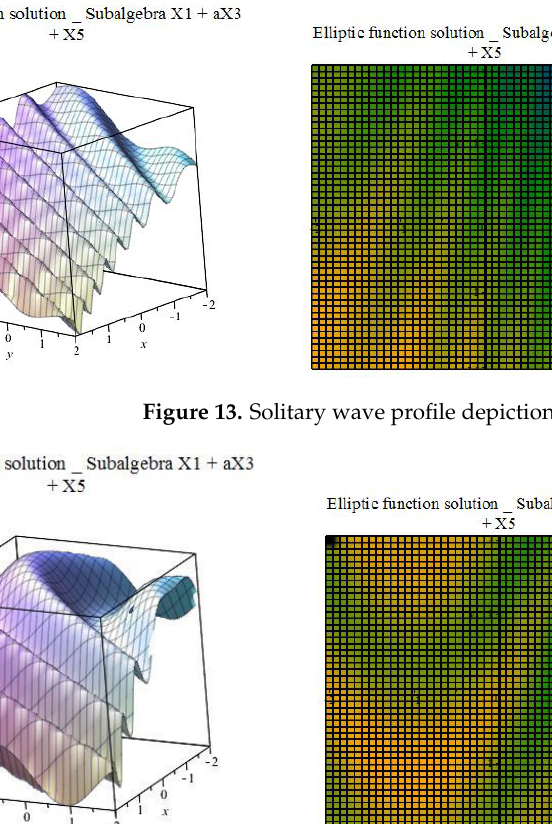
Figure 12. Solitary wave profile depiction of elliptic solution (84) at t = 2.